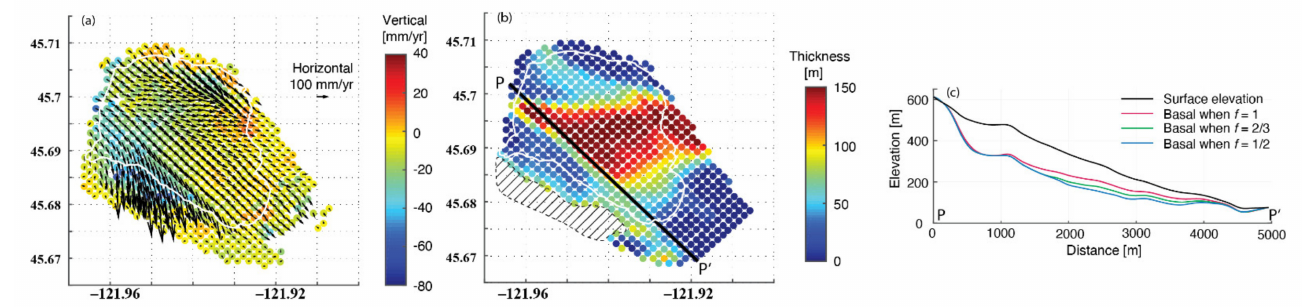
Figure 6. ( a ) Displacement velocity maps of Crescent Lake landslide. ( b ) Landslide thickness with rheology parameter f = 2/3. ( c ) Profiles of surface elevation and landslide basal surface elevations with different rheology parameters along the transect P-P’ shown in ( b )